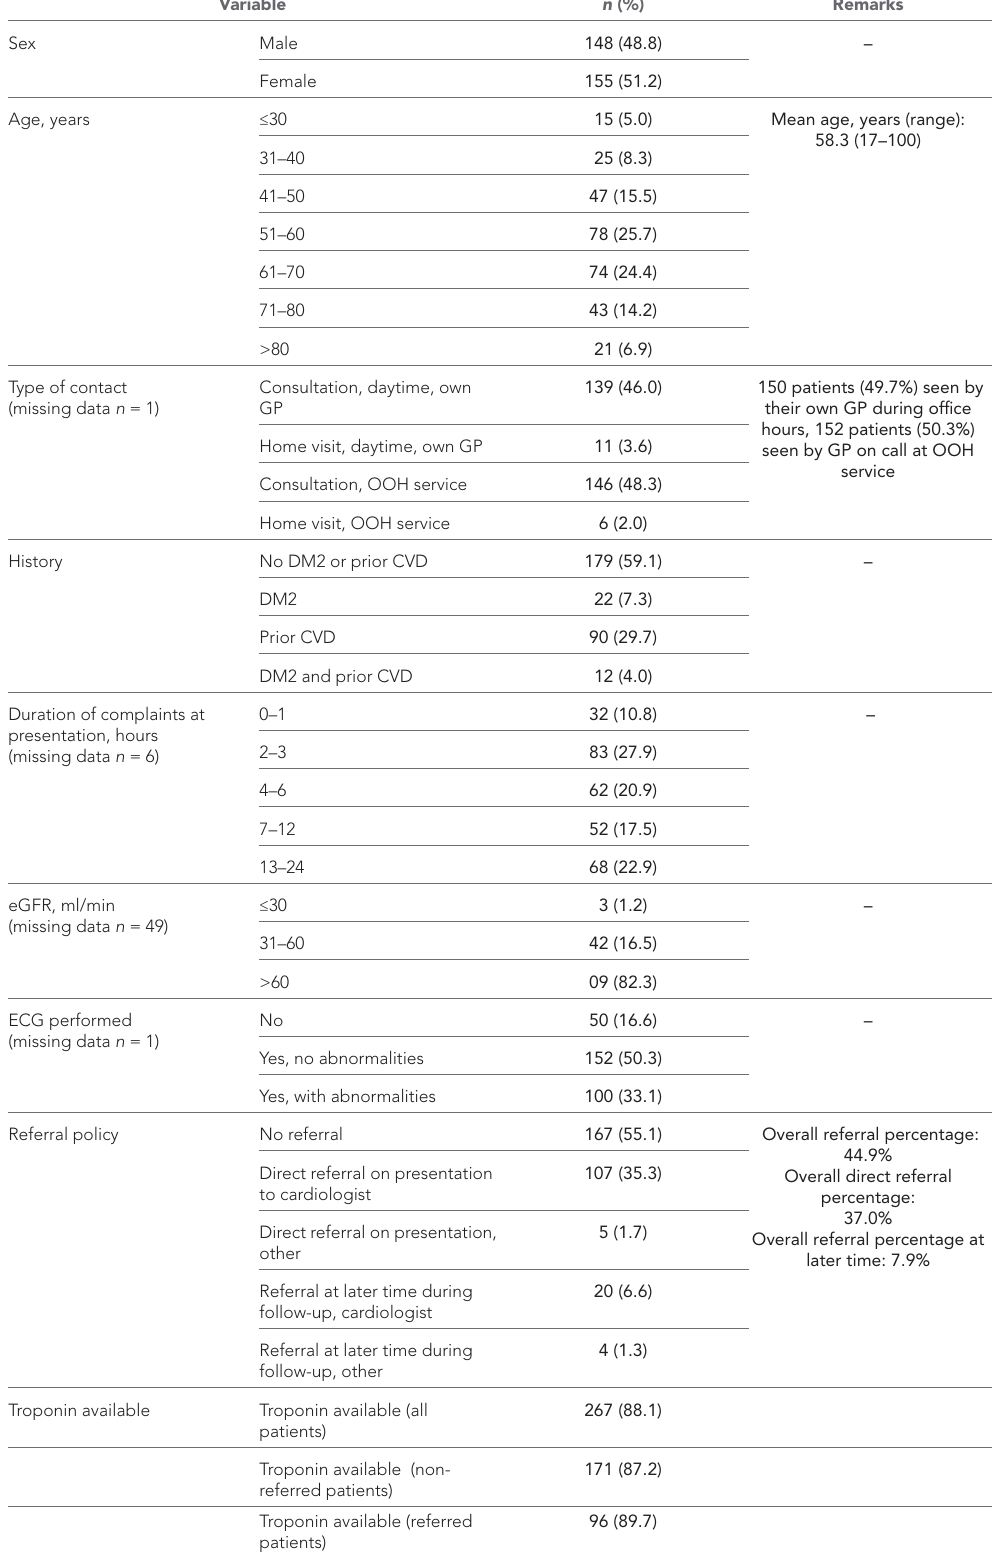
Table 1 Patient and population characteristics of study population ( n = 303)